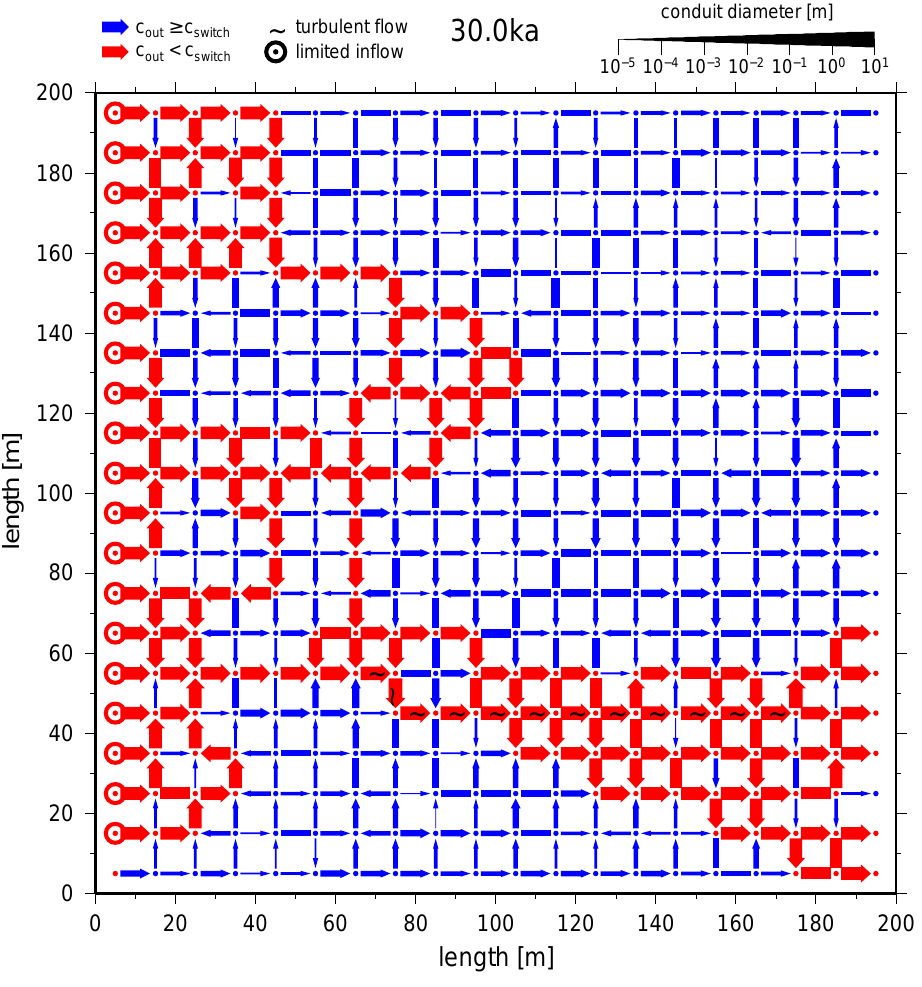
Fig. 2. Example of a conduit pattern at a late stage (30ka) of karst evolution after breakthrough showing one realisation with high initial protoconduit aperture heterogeneity and an intermediate total maximum recharge rate of Q max = 10 − 3 m 3 s − 1 . Filled circles represent nodes. Rings mark nodes located at the recharge side which reached maximum inflow rates of q max = 5 × 10 − 5 m 3 s − 1 . Single tubes are shown as arrows indicating flow direction. The width of the arrows represents the aperture size and tildes denote regions with turbulent flow. Red colour indicates regions where first-order dissolution kinetics is